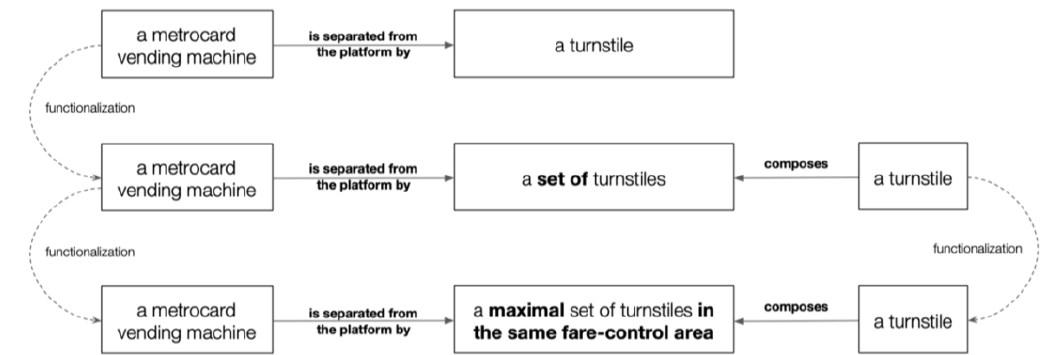
Figure 1. Turning the relationship between a metrocard vending machine and a turnstile into a morphism. Note that this process revealed the existence of another entity–“a maximal set of turnstiles in the same fare-control area”–inferreable from the original instances, and another